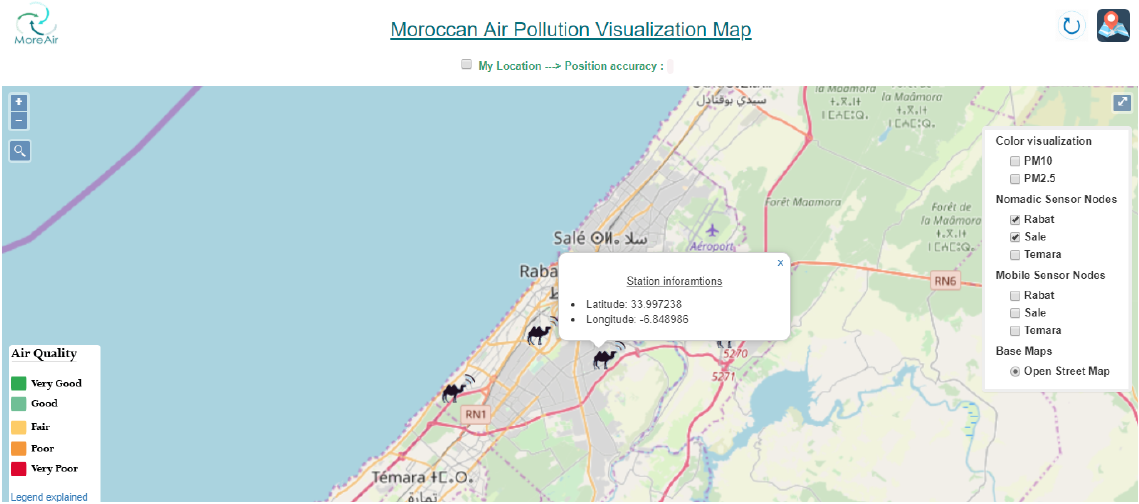
Figure 17. Visualization of nomadic sensor nodes and their location